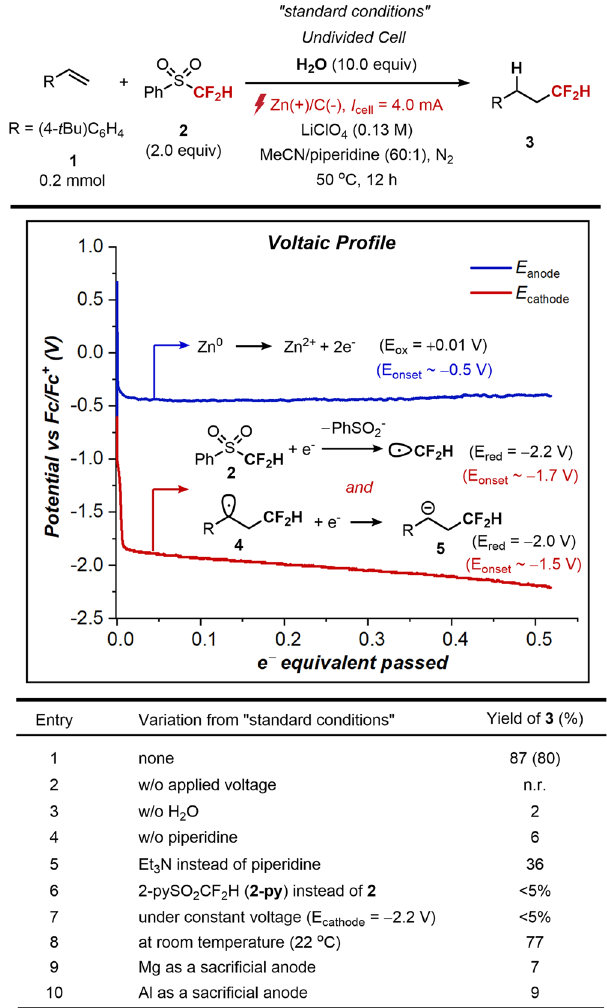
Fig. 3 Reaction parameter optimization. Yields determined by 1 H NMR using CH 2 Br 2 as an internal standard (isolated yields in parenthesis). The voltaic pro fi le ofeachelectrodeduringelectrolysisofentry1isshown(insetbox).Thesacri fi cial Zn anode operates at the anticipated onset potential for Zn oxidation (blue line, E onset = ca. − 0.5VvsFc/Fc + ).Theinitialcathodicpotential(E cathode = − 1.8V)is in accordance with the onset potential for reduction of 2 (red line). Under the given cathodic potential, a simultaneous reduction of benzylic radical intermediate 4 into corresponding carbanion 5 is also